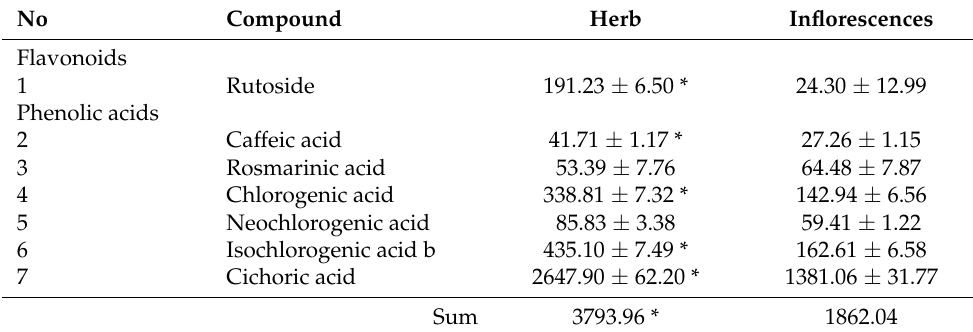
Table 4. The content of detected phenolic compounds (mg × 100 g − 1 DW).